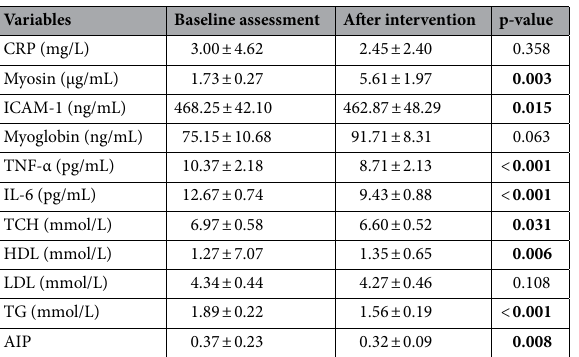
Table 3. Biochemical data. CRP C-reactive protein, ICAM-1 intercellular adhesion molecule-1, TNF-α tumor necrosis factor alpha, IL-6 interleukin 6, TCH total cholesterol, HDL high-density lipoprotein, LDL low-density lipoprotein, TG triglyceride, AIP atherogenic index of plasma (AIP).